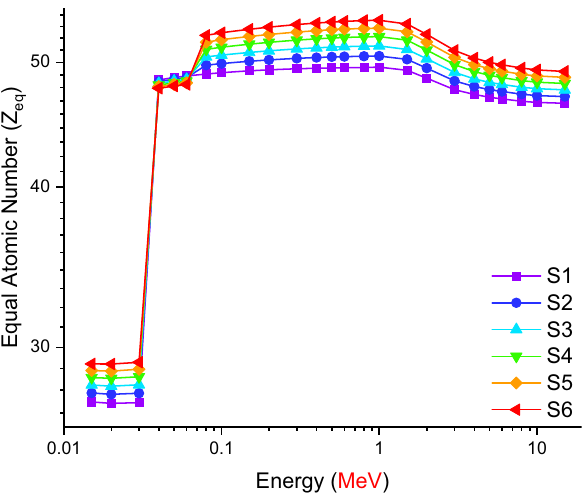
Figure 4: Variations of equivalent atomic number ( Z eq ) with photon energy ( MeV ) for all S1 – S6